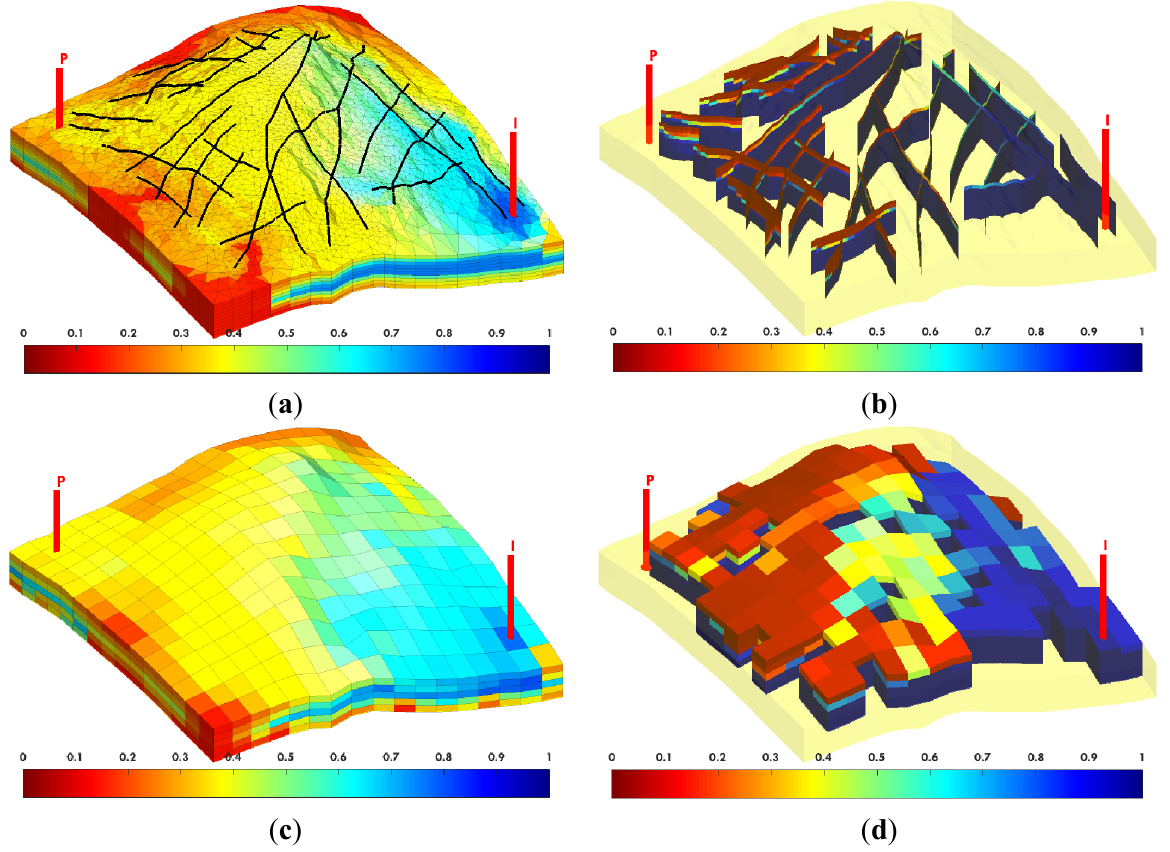
Figure 18. BHP of injection well for case 3.